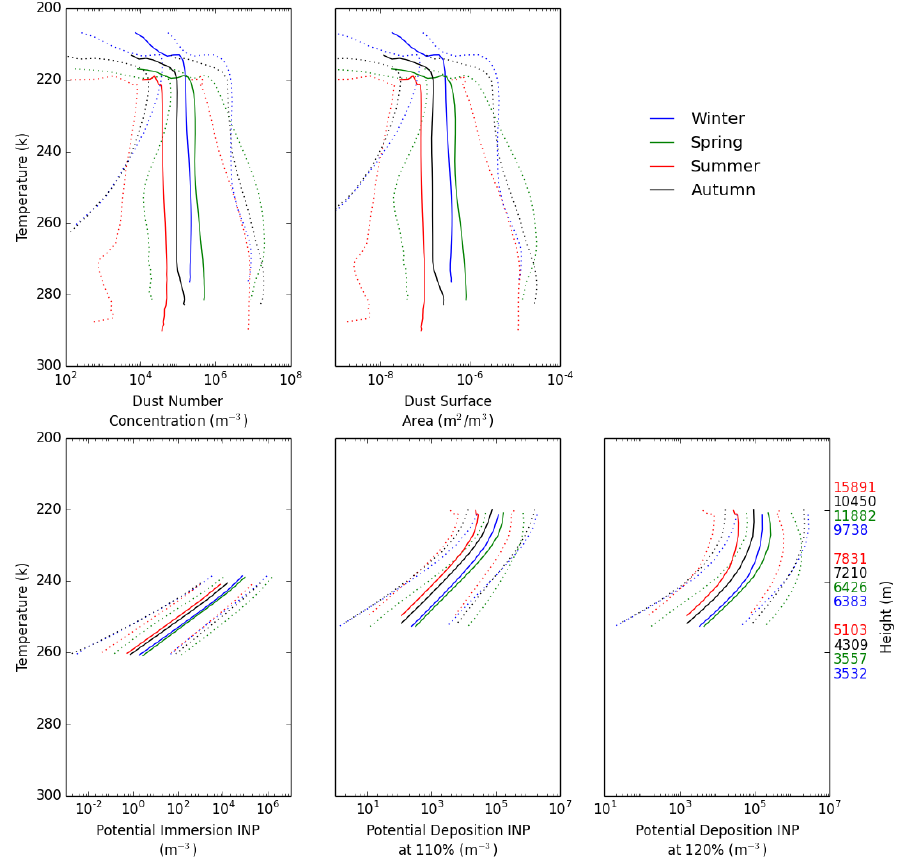
Figure 1. Median (solid), 5th and 95th percentiles (dotted) for total dust number concentration, total dust surface area, potential immersion INP, and potential deposition INP at RH ice of 110 and 120% over Europe (44–60 ◦ N and 0–20 ◦ E) for winter (blue), spring (green), summer (red) and autumn (black). The Niemand et al. (2012) parameterisation is valid between 237.15–261.15K, and the Steinke et al. (2014) parameterisation is valid from